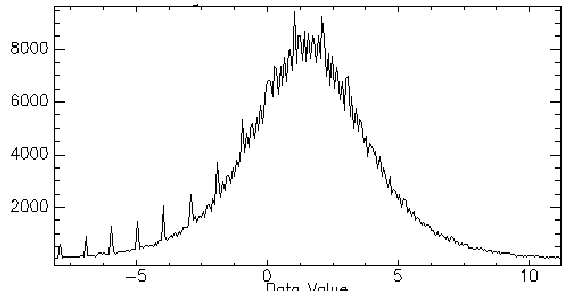
Figure 8. Frequency distribution of the differential DEM between the ZY-3 DEM and SRTM DEM